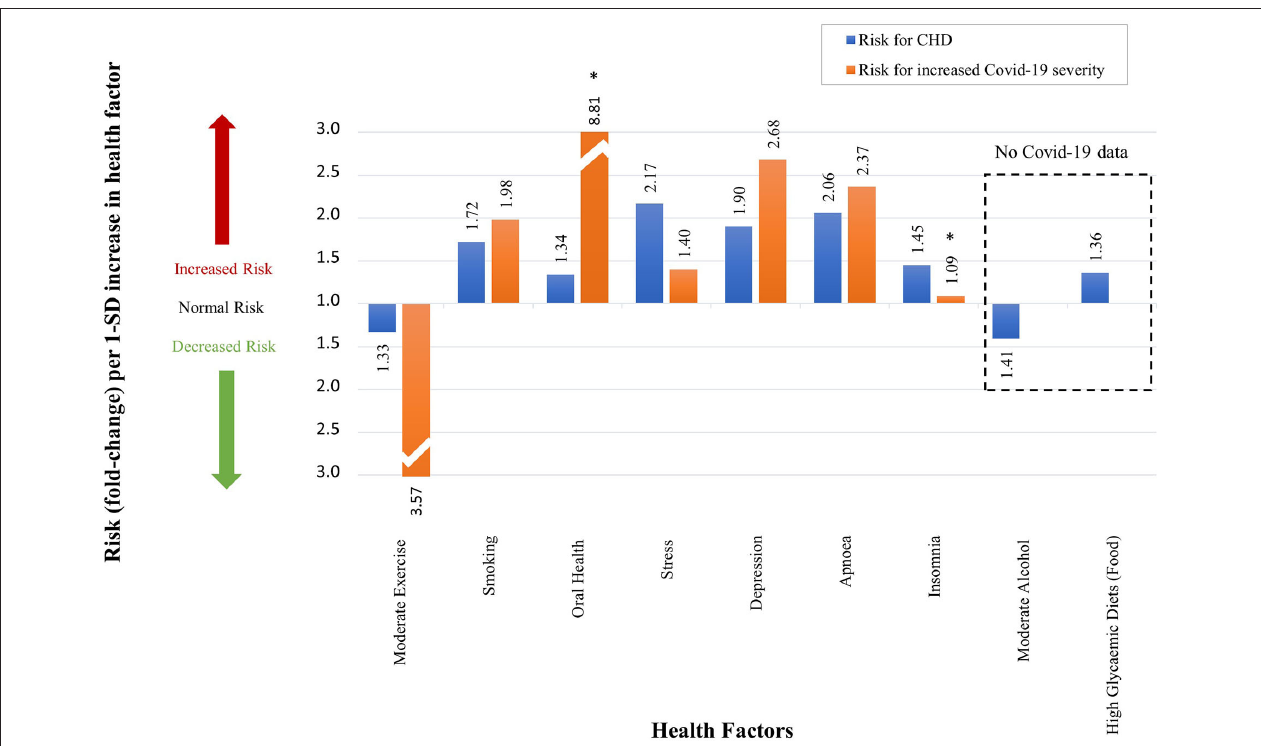
FIGURE 11 | The qualitative effect which different health factors have on CHD risk and Covid-19 severity. (An accurate quantitative comparison is not possible, mostly due to differences in study design and size).